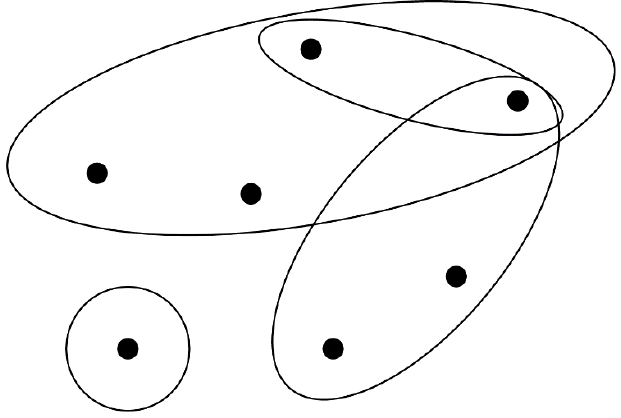
Figure 2. An illustration of one hypergraph: the dots represent the vertices, and the closed curves denote the hyperedges.